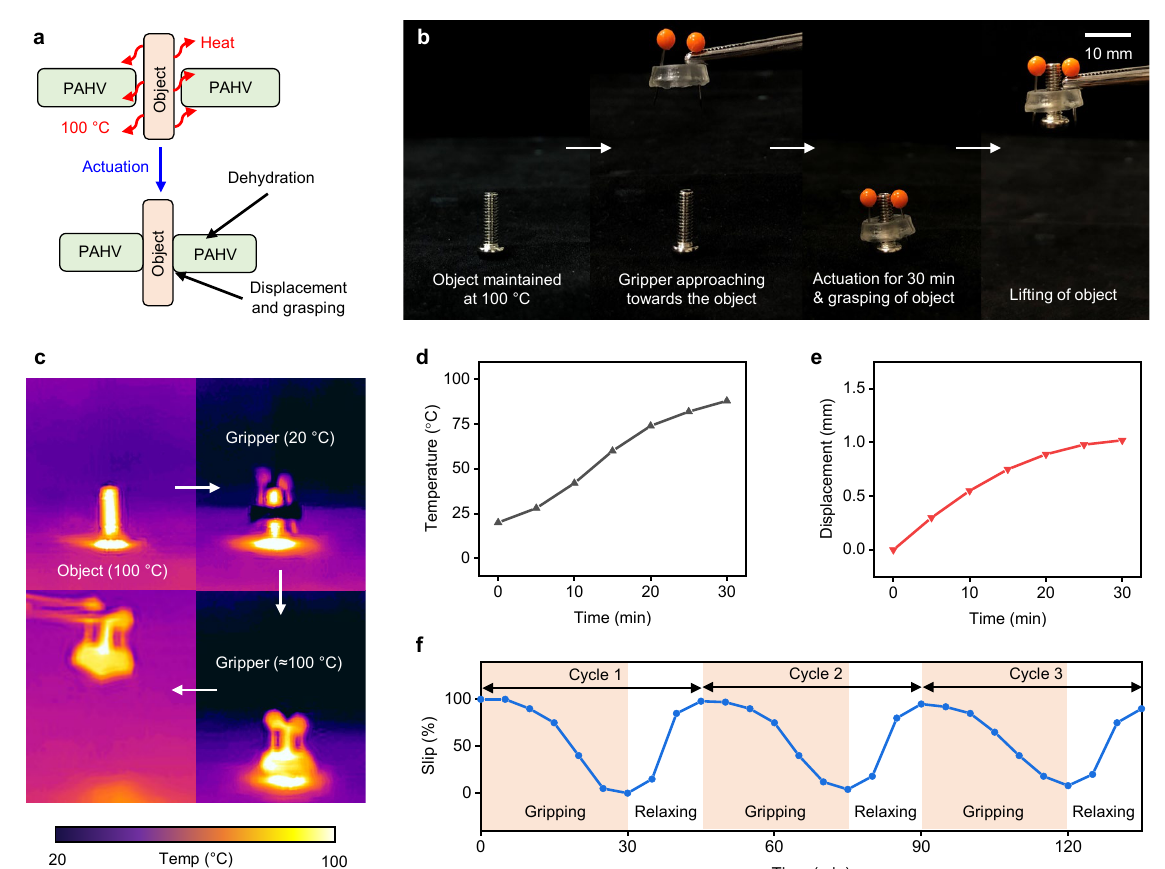
Figure 11. PAHV performance in a gripping application. ( a ) Schematic showing grasping mechanism of the PAHV gripper. ( b ) Time-lapse images demonstrating the PAHV grasping. ( c ) IR images exhibiting the PAHV gripper’s actuation when the object is at 100 ◦ C. ( d ) Temperature in the PAHV when the object is at 100 ◦ C. ( e ) Displacement in the PAHV when the object is at 100 ◦ C. ( f ) Object slipping in the PAHV gripper during grasping for 3 cycles when object is at 100 ◦